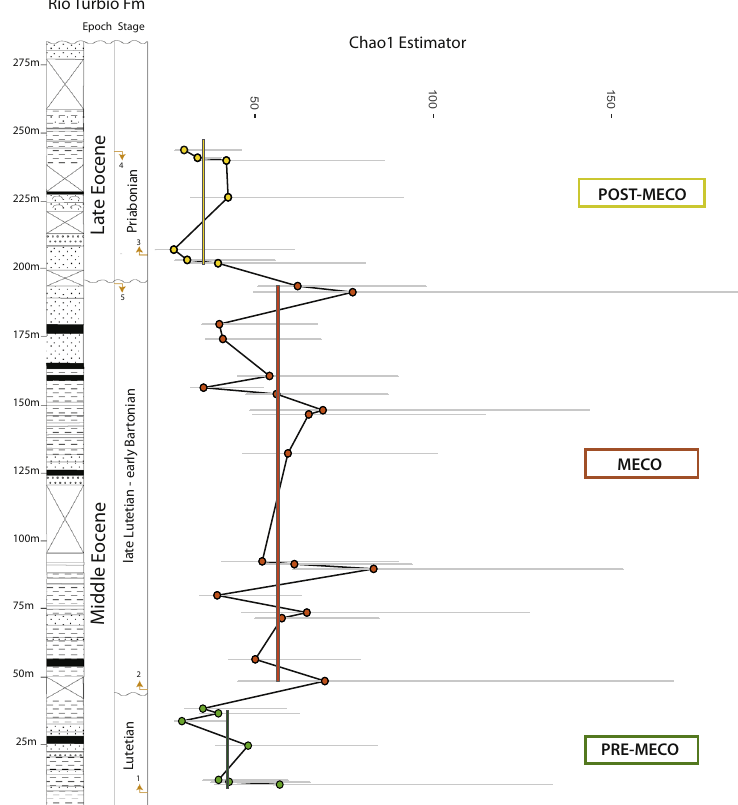
Fig. 3 Floristic diversity across time in southern Patagonia. Within-sample Chao1 estimated richness with bootstrapped 95% con fi dence intervals for pre- MECO (green), MECO (dark-orange) and post-MECO (yellow) samples from southern Patagonia the composite section of the Río Turbio Formation (see references in Supplementary Fig. 1). Vertical bars denote mean Chao1 diversity within each major group of samples (or intervals) detected from the continental constrained cluster analysis. Note that, in average, the within-sample Chao1 estimator is ~40% higher during the MECO than pre-MECO and post-MECO intervals. See Table 1 for further details. Arrows at the Stage column indicate major dinocyst events from the sampled composite section of the Río Turbio Formation; (1) Lowest Common Occurrence of E. dictyostila ; (2) Highest Common Occurrence of E. dictyostila ; (3) Lowest Common Occurrence of T. fi losa ; (4) Highest Occurrence of T. fi losa ; (5) Highest Common Occurrence of E. dictyostila . See Supplementary Fig. 5 for further details.